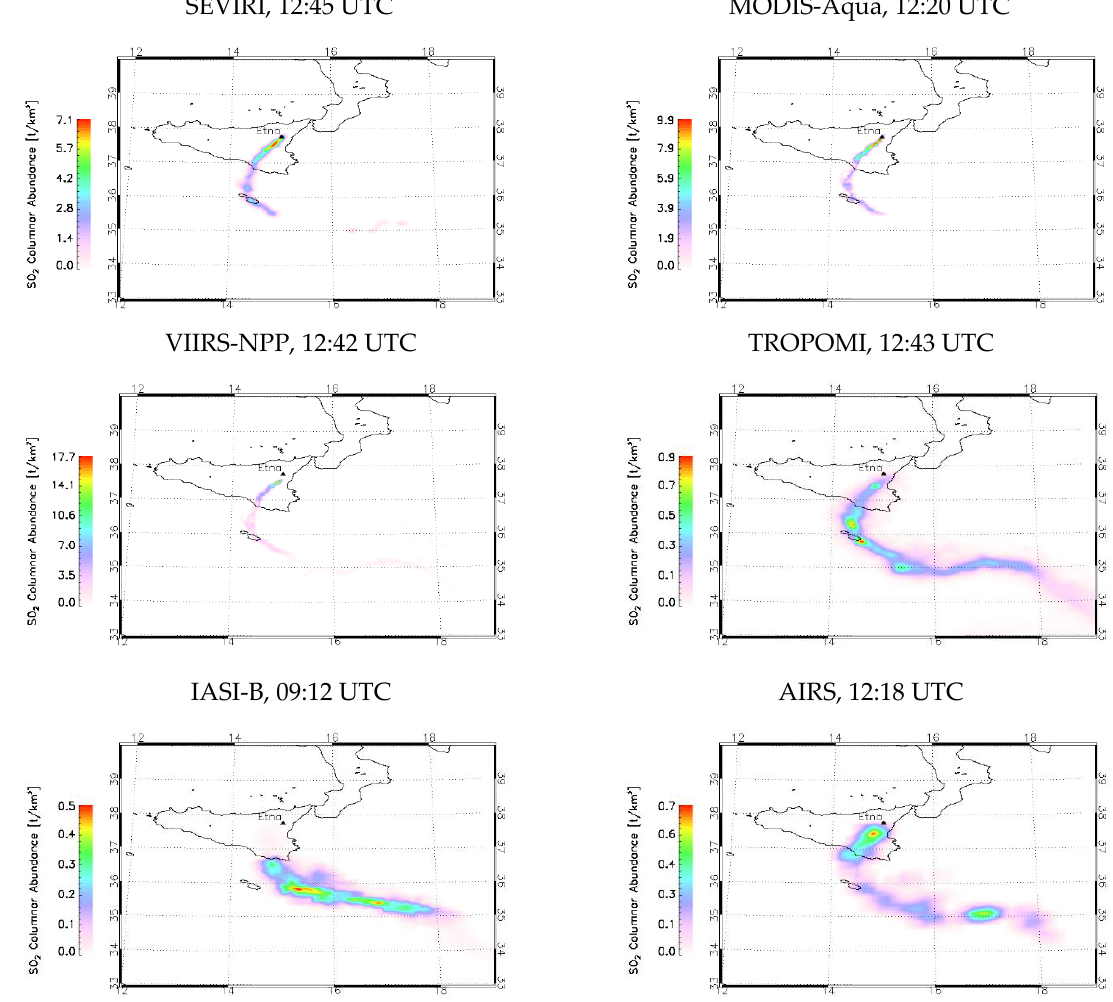
Figure 5. Near simultaneous SO 2 maps obtained from the different satellite measurements, collected on 27 December 2018 at around 12:30 UTC (except IASI, collected at 09:12 UTC).